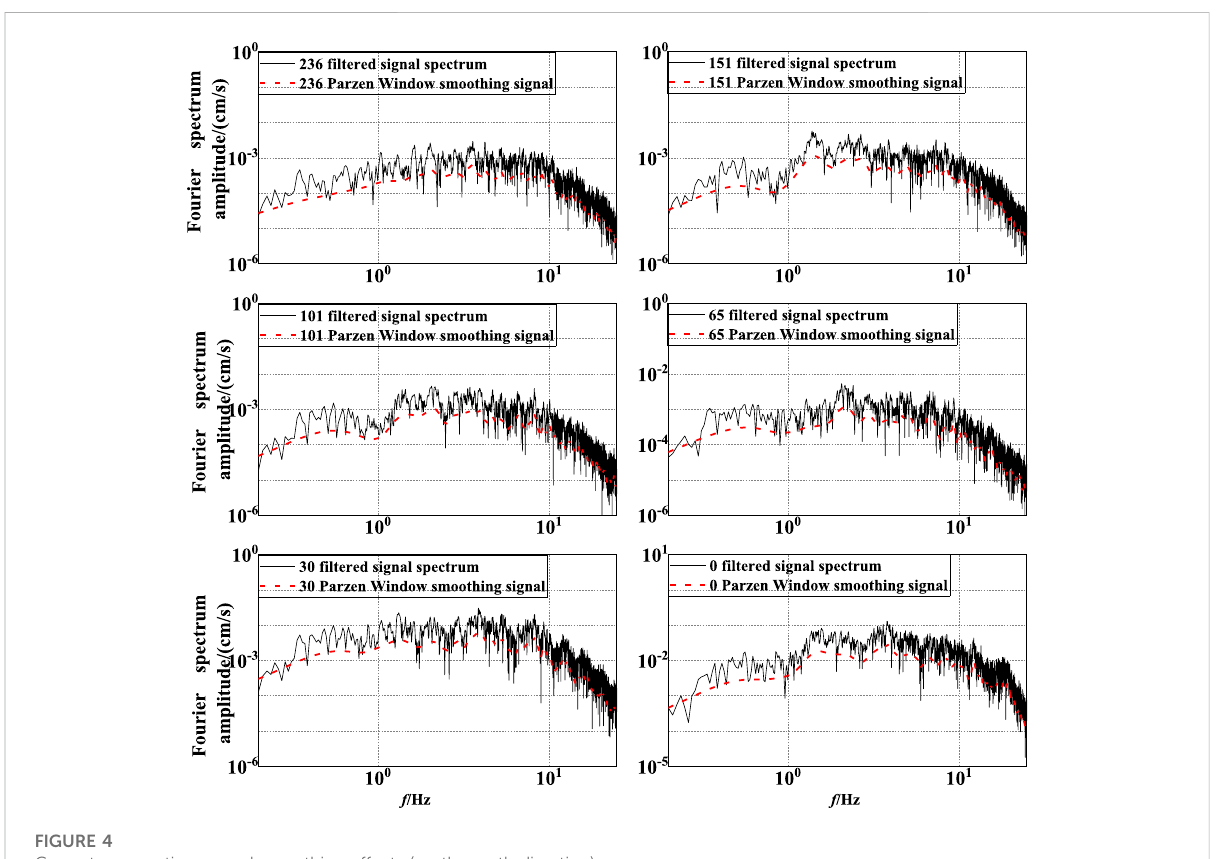
FIGURE 4 Guye strong motion record smoothing effects (north – south